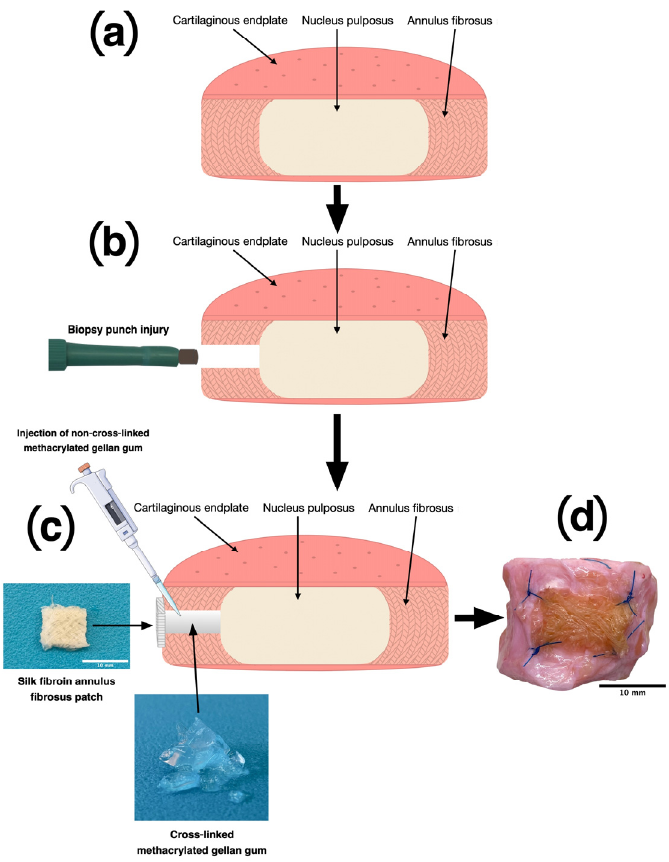
Figure 1. ( a ) Cross-section of a healthy bovine intervertebral disc with nucleus pulposus, annulus fibrosus, and cartilaginous endplates, ( b ) damage of the annulus fibrosus using a biopsy puncher, ( c ) repair of the damage using 2% GG-MA and a silk yarn fabric, ( d ) photograph of a repaired intervertebral disc. Adapted with permission from [31], © MDPI, Basel, IJMS.